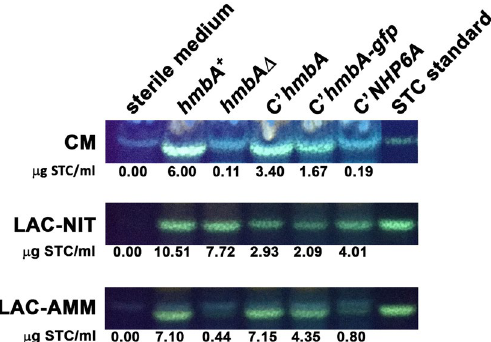
Figure 8. Sterigmatocystin production on various media in hmbA + control, hmbAΔ and various complemented hmbAΔ strains detected by TLC and quantified by HPLC. CM: complete medium, LAC-NIT: minimal medium with lactose carbon-source and sodium-nitrate nitrogen-source; LAC-AMM: minimal medium with lactose carbon-source and diammonium L-(+)-tartrate nitrogen-source. Used strains were hmbA + as control (HZS.120); hmbAΔ ( hmbA deletion strain, HZS.320); C’hmbA ( hmbAΔ complemented with hmbA , HZS.621), C’ hmbA-gfp ( hmbAΔ complemented with hmbA-gfp , HZS.371); C’ NHP6A ( hmbAΔ complemented with NHP6A , HZS.834). Sterile medium was used as negative control. STC is sterigmatocystin standard (Sigma). The complete genotypes are listed in Supplementary Table S2. The original TLC images are presented in Supplementary Fig. S4 c